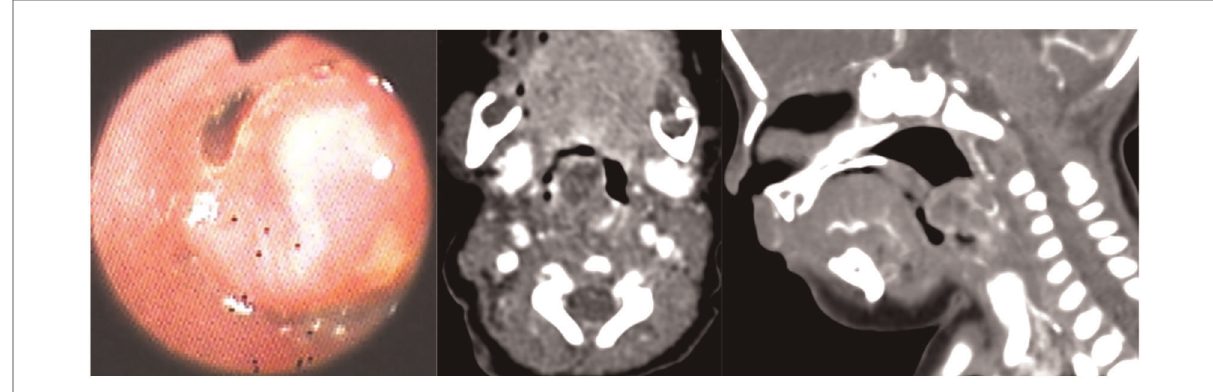
FIGURE 1 A 19-hour-old female. ( A ) Fiberoptic laryngoscopy showed a large globular mass (white arrow) with a smooth mucosal surface in the posterior pharyngeal wall. CT revealed a 1.4-cm sized cystic lesion in the posterior pharyngeal wall (red circle): ( B ) axial contrast-enhanced CT; ( C )